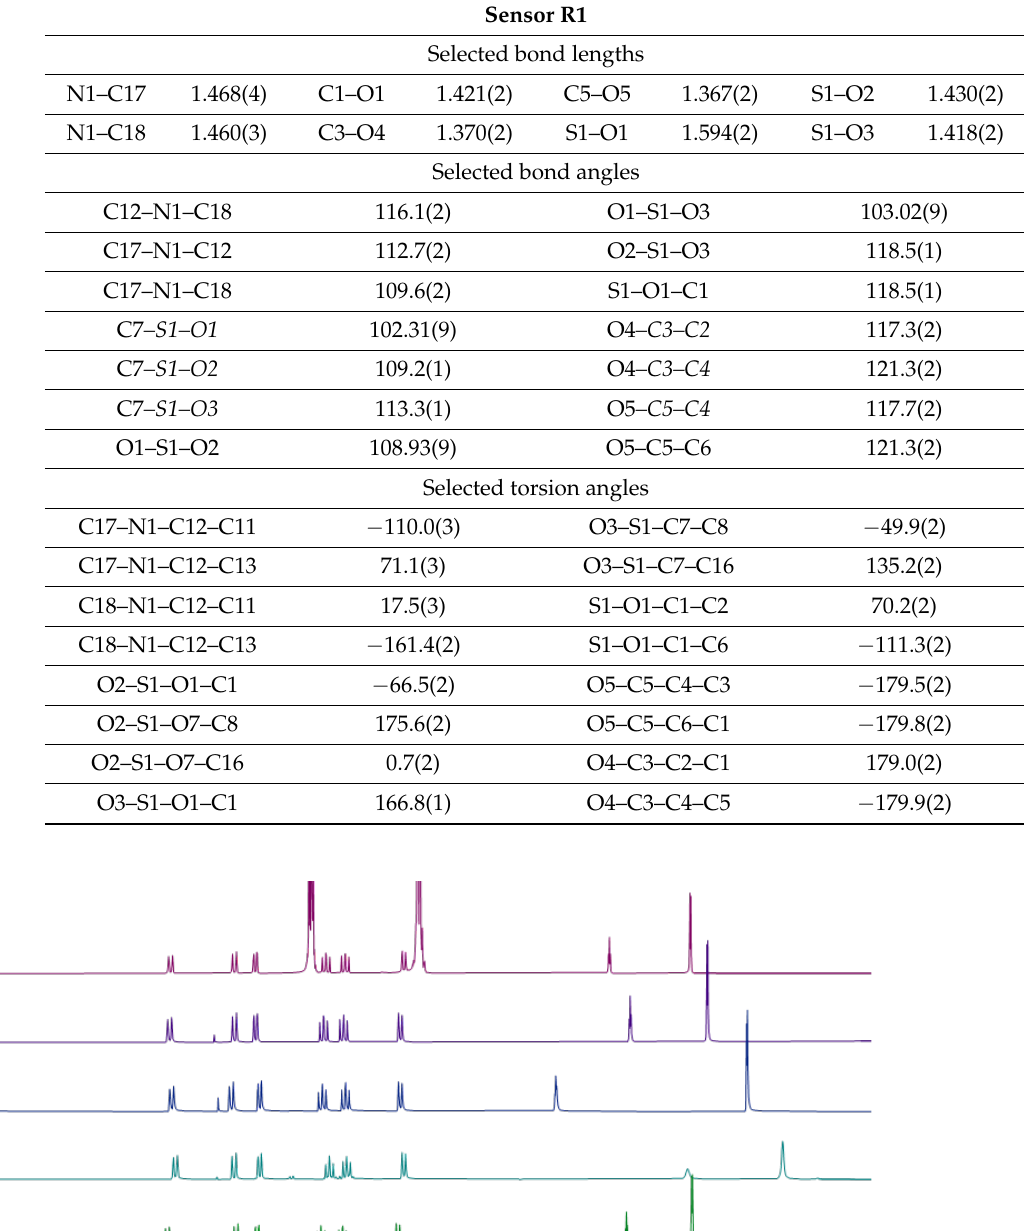
Table 2. Selected bond lengths (Å), bond angles ( ◦ ) and torsion angles ( ◦ ) in sensor R1. Sensor R1